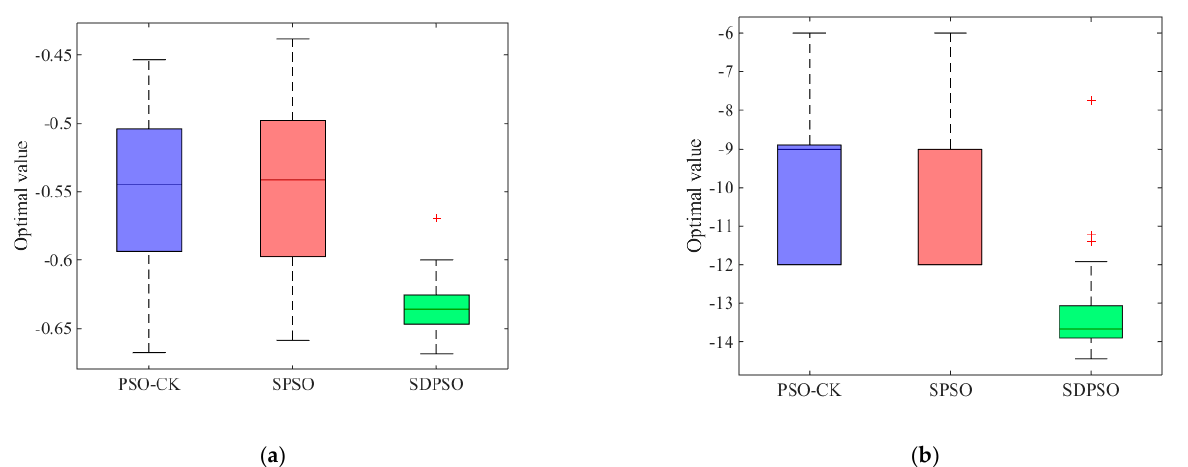
Figure 6. Boxplots of the optimal values of 25 repetitions obtained by PSO-CK, SPSO, and SDPSO, respectively, for each benchmark optimization problem. ( a ) BOP1; ( b ) BOP2. Table 3. Mean, minimum, and standard deviation values of the optimal values of 25 repetitions, obtained by PSO-CK, SPSO, and SDPSO for each benchmark optimization problem, respectively. Problems Criteria